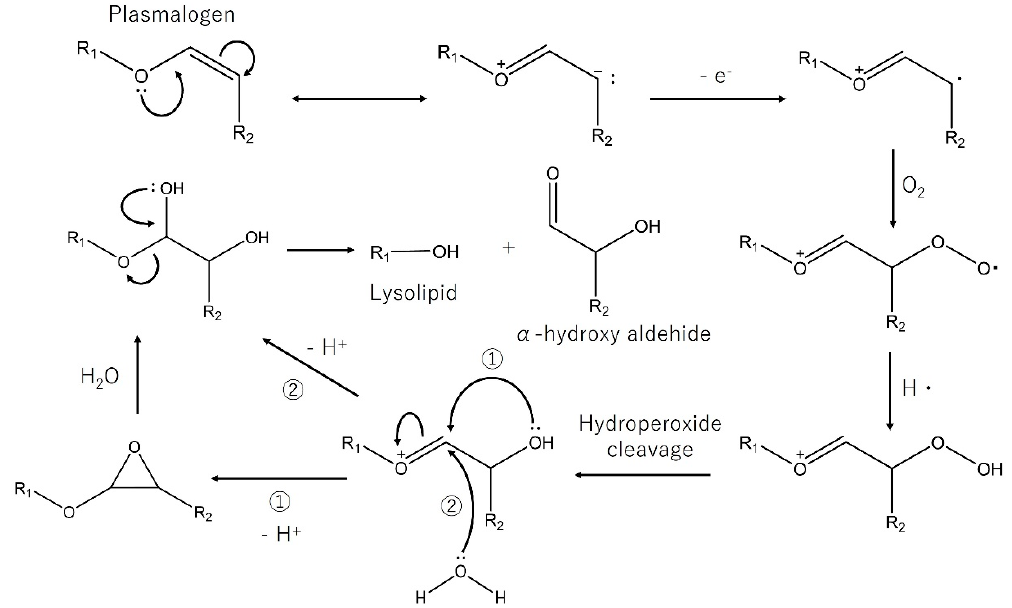
Figure 4. Proposed oxidative mechanism of plasmalogen. Modified from [88] with permission from The American Society for Biochemistry and Molecular Biology.